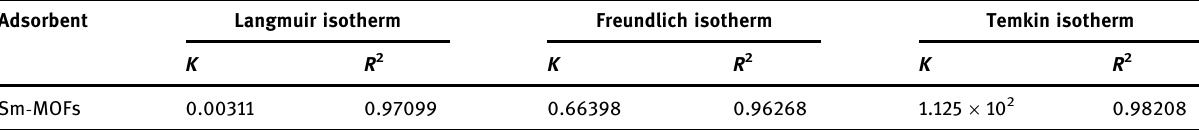
Table 3: Adsorption isotherm parameters of CR onto Sm - MOFs at room temperature Adsorbent